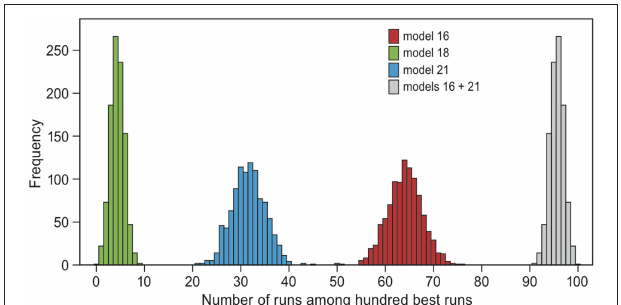
FIGURE 4 | Bootstrapping test of model selection. The ABC-analysis was repeated 100 times, each time using a randomly drawn 50% of all simulation runs. Plotted are the frequency distributions of the representation of each model among the 100 best simulation runs in each repeat, excluding zero. The only models that always occurred among the selected runs are models 18 (green, mean 4), 21 (blue, mean 32) and 16 (red, mean 64). Models 16 = = = and 21 together always represented at least 91 of the 100 selected runs (gray, mean 96). These are two models that include “reconsider geese ”, “grouping”, = and an age-effect on “grouping.” Model 21 additionally includes “memory” (see Table 2 and Figure 2